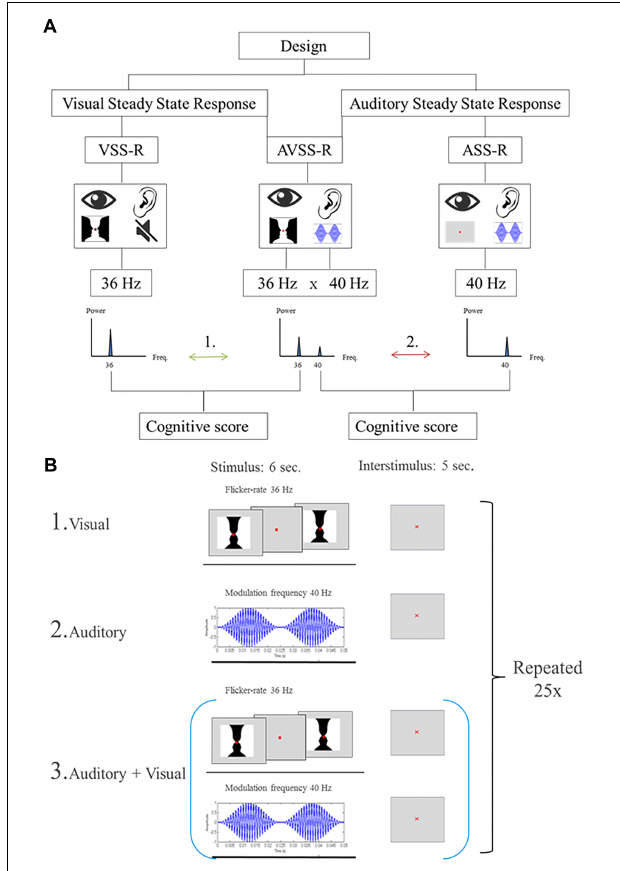
FIGURE 2 | (A) Flowchart of the stimulations. The numbers (1, 2) indicate the two main hypotheses, investigated in the paper: Arrow 1: The correlations between 36 Hz-steady state power response to visual, or the audiovisual, stimulation and intelligence. Arrow 2: The correlations between intelligence and 40 Hz-steady state power response to an auditory or audiovisual stimulation. (B) Illustration of the stimulation procedure for extracting 6 s stimulation epochs. The start of each stimulation is indicated by a trigger signal. (B1) Schematic of the stimulation procedure with an image flickering at a of 36 Hz. (B2) Schematic of the stimulation procedure with AM-modulated carrier wave at 1 kHz with a modulation frequency of 40 Hz. (B3) Schematic of the combined stimulation procedure with both single-sensory